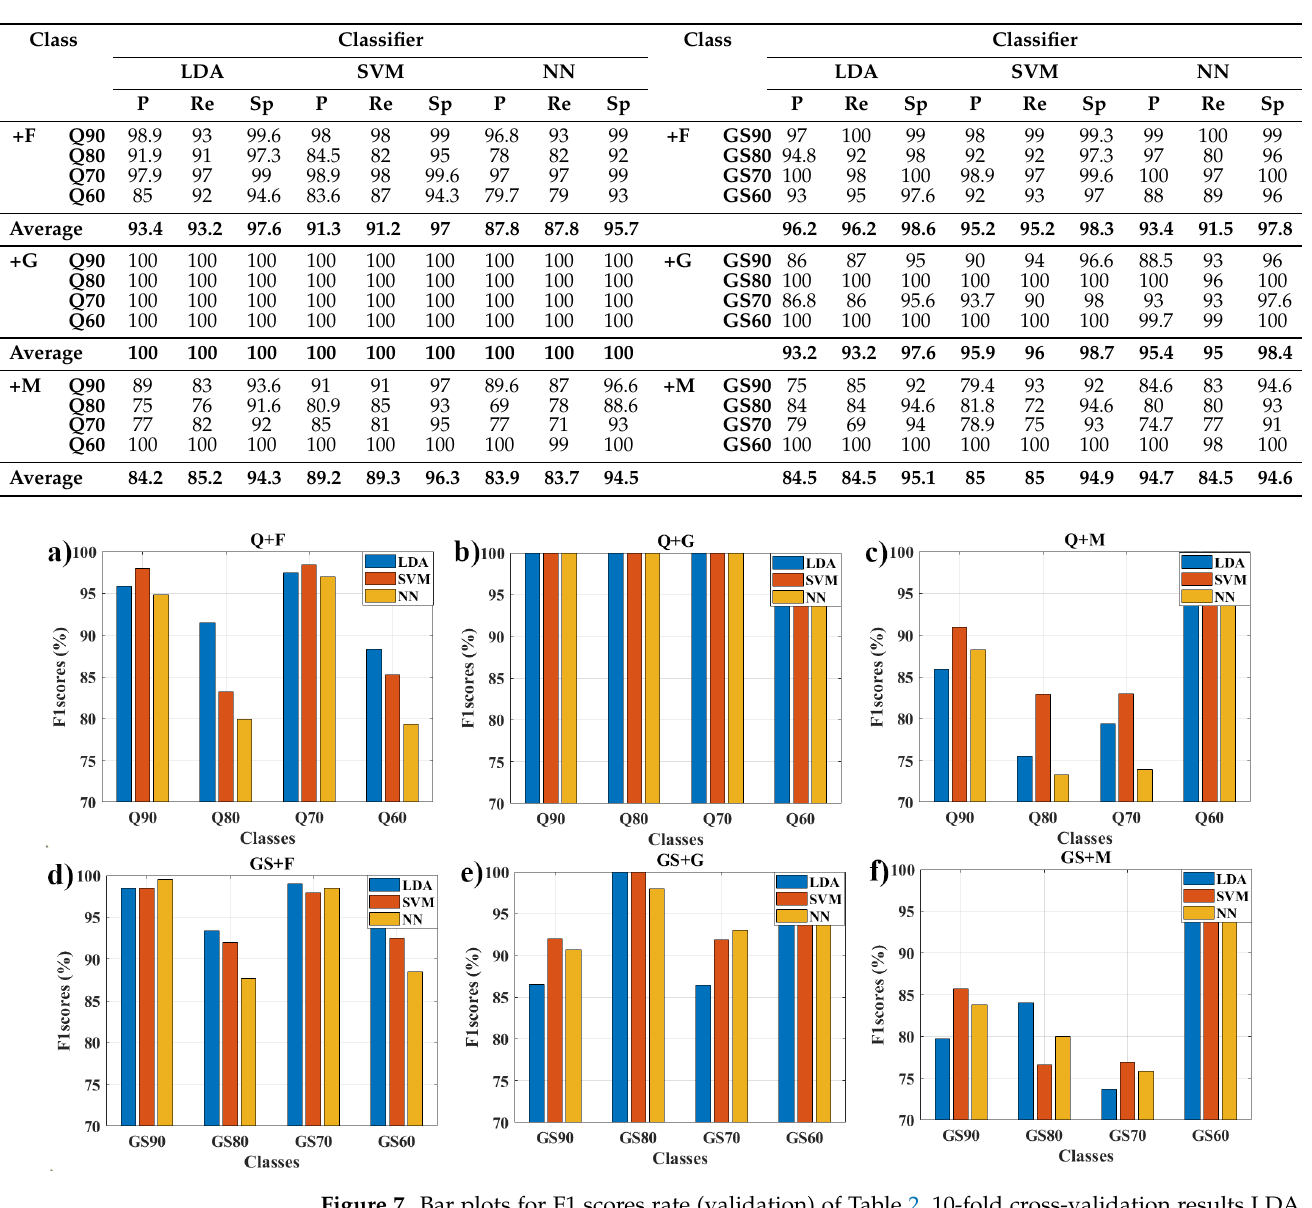
Table 2. The Precision (P), Recall (Re), and Specificity (Sp) metrics obtained for 10-fold cross-validation in each class are shown.